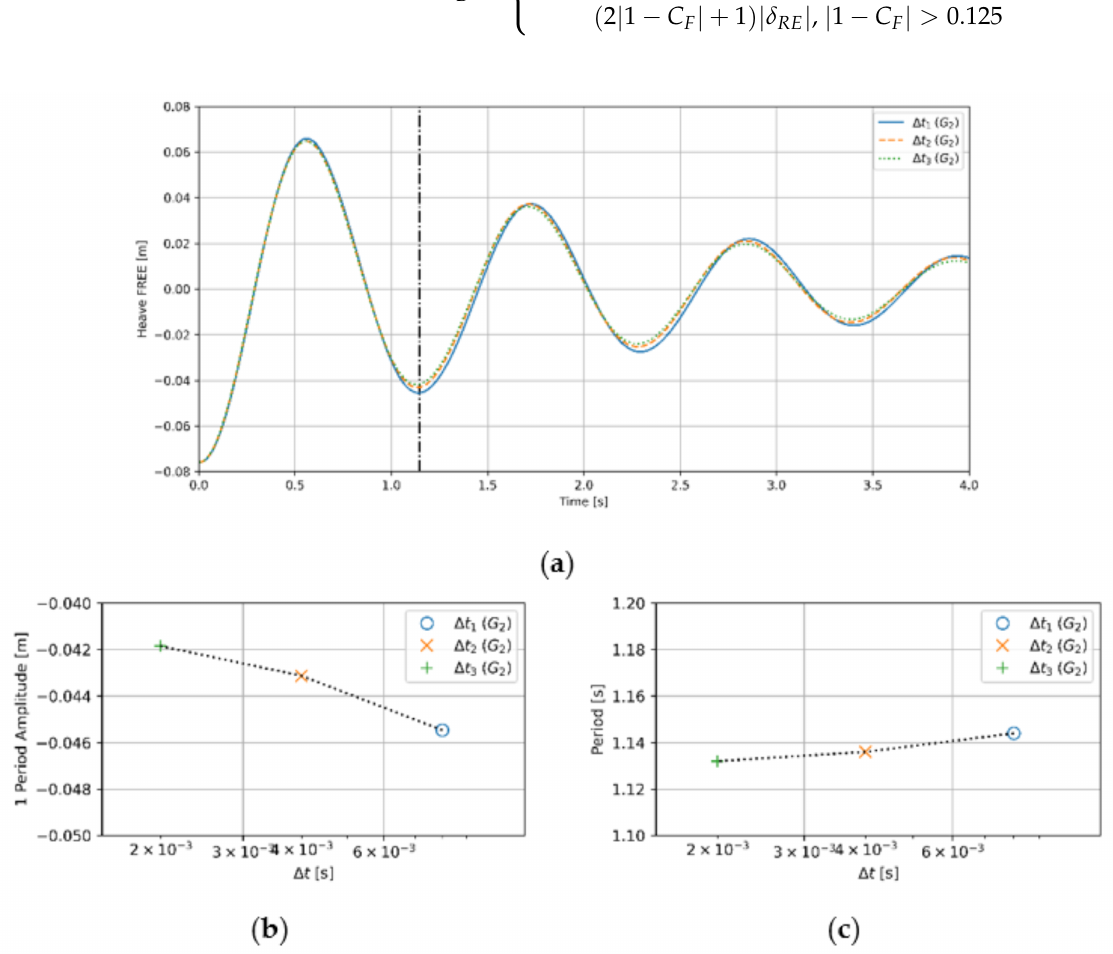
Figure 7. Time histories freely decaying heave motions: ( a ) the associated amplitude; ( b ) period; ( c ) of the first oscillation period obtained on grids G 1 , G 2 , and G 3 for the time-step size